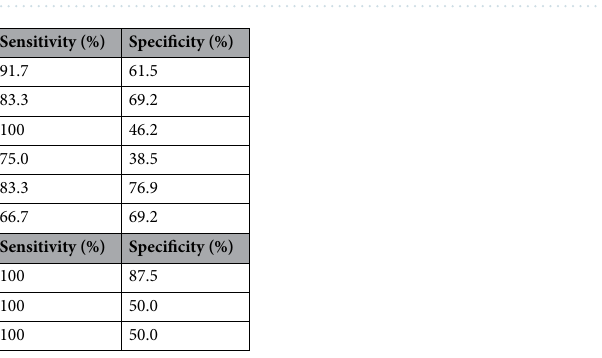
Figure 3. Association between MMPs in CSF and outcome in TBI patients (at time point 1). The horizontal lines represent the median and interquartile ranges. Statistical significance in CSF MMP concentrations between favourable (GOS = 4–5) and unfavourable (GOS = 1–3) outcomes at the baseline following TBI: *p ≤ 0.05. Analysis of covariance was used to examine the differences between the groups, accounting for the effect of age. N (number of patients): n = 12 for favourable, n = 13 for unfavourable.